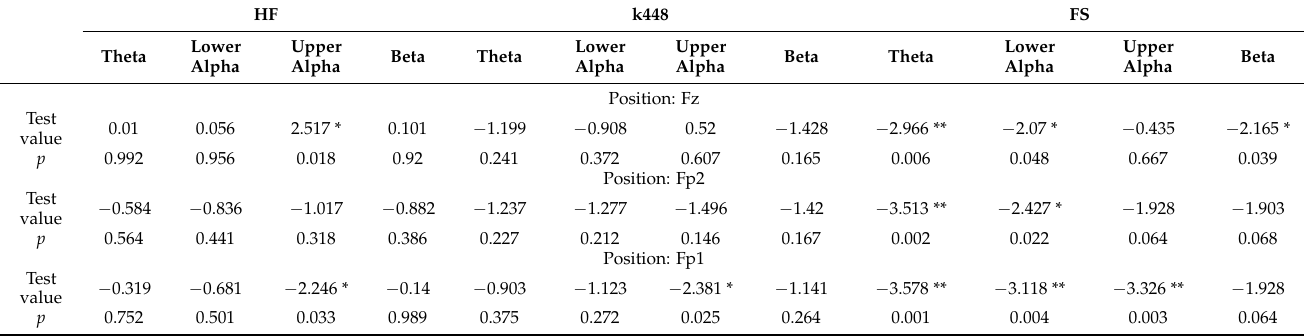
Table 2. Summary of theta, lower alpha, upper alpha, and beta power at different positions around baseline at corresponding positions using the paired-sample t